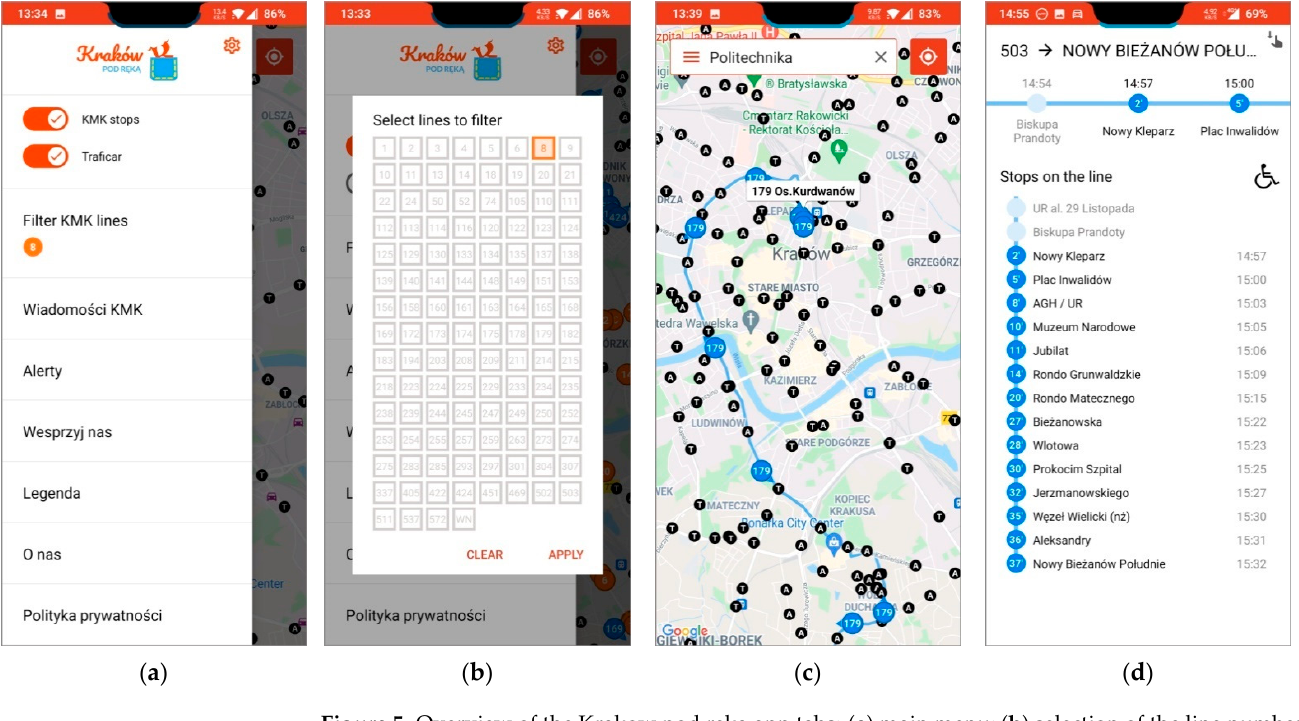
Figure 5. Overview of the Krakow pod r ę k ą app tabs: ( a ) main menu; ( b ) selection of the line number to be filtered; ( c ) visualisation of the public transport line route; ( d ) list of stops of the given public transport line.